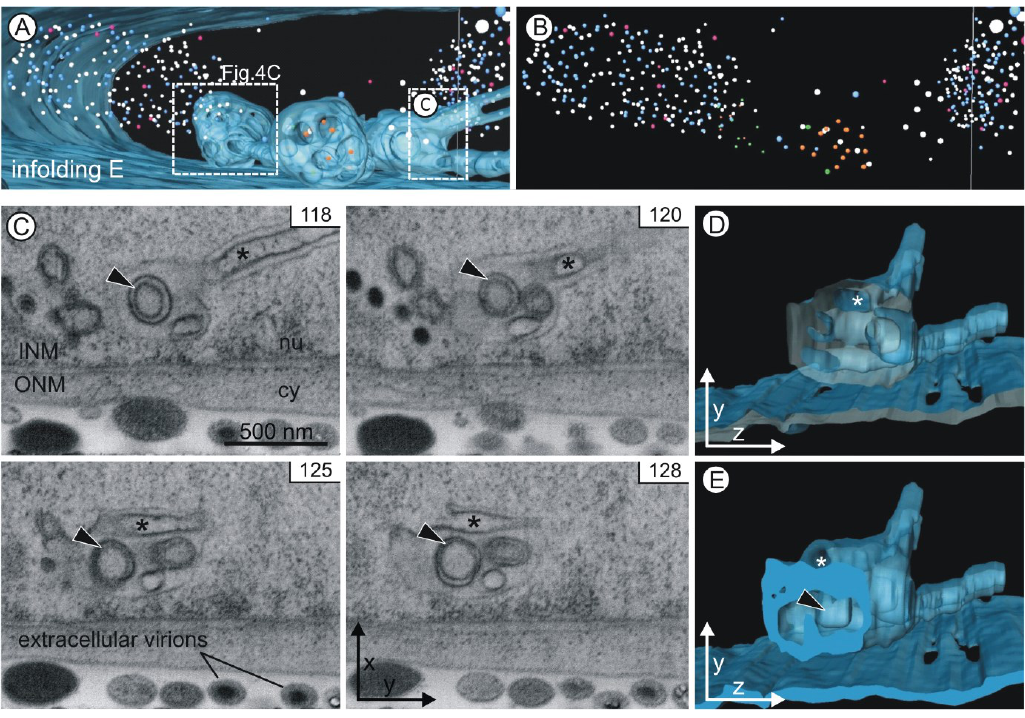
Figure 5. Infolding E. ( A ) Two large spherical segments (diameters 1 µm) are connected by a tubular segment (diameter ~180 nm). A smaller spherical segment at the front branches out into two tubular segments. The boxes mark the position of the details depicted in Figures 4C and 5C–E. ( B ) Presentation of the capsids alone shows the cloud-like structure of the nucleoplasmic capsids. ( C ) A 3rd order infolding (arrowhead) is visible in a sequence of more than ten images (see Movie S4). The images also show an invagination within the tubular segment (asterisk). Its connection with the nucleoplasm is evident in image 128. INM inner nuclear membrane, ONM outer nuclear membrane, nu nucleoplasm, cy cytoplasm. ( D,E ) The yz view of the three-dimensional model shows the opening of the invagination (asterisk). The model is depicted without capsids.